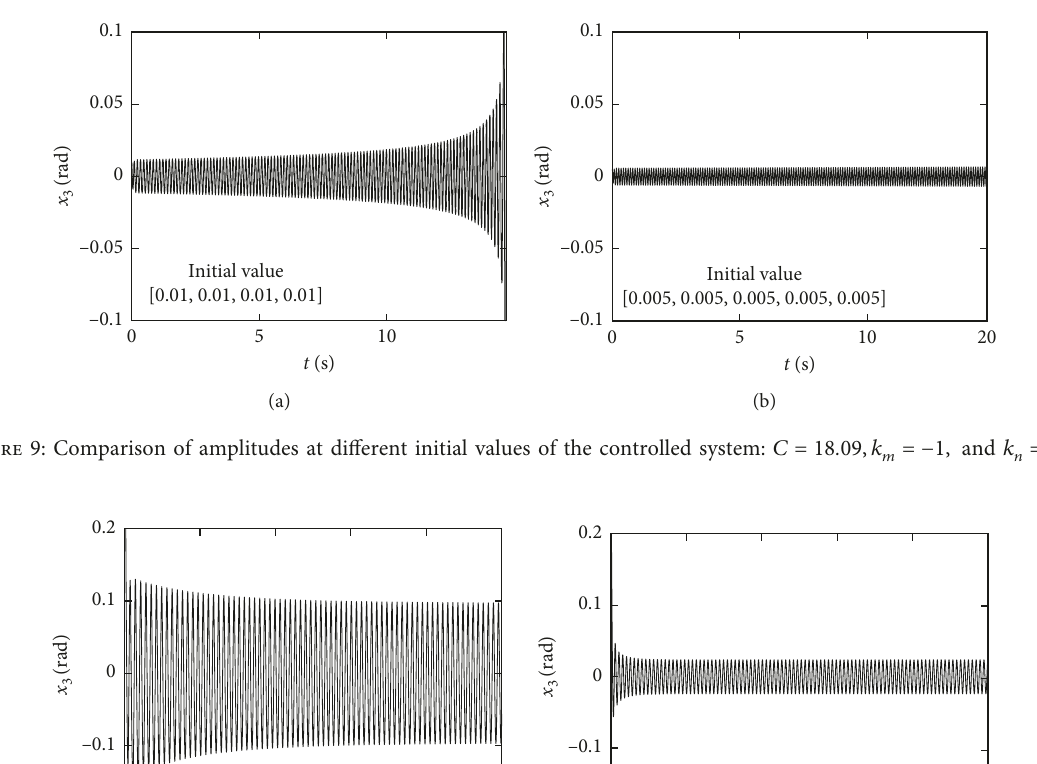
Figure 10: The amplitude contrast diagram of the original and controlled systems at C